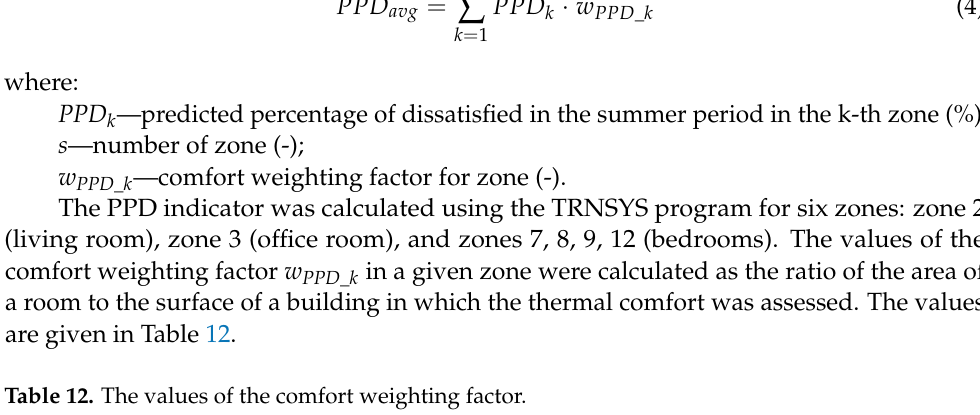
Table 12. The values of the comfort weighting factor. Zone